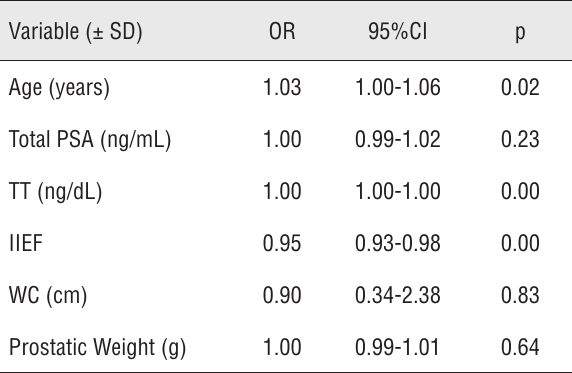
Table 3 - Logistic regression analysis for the occurrence of severe LUTS among patients with BMI ≥